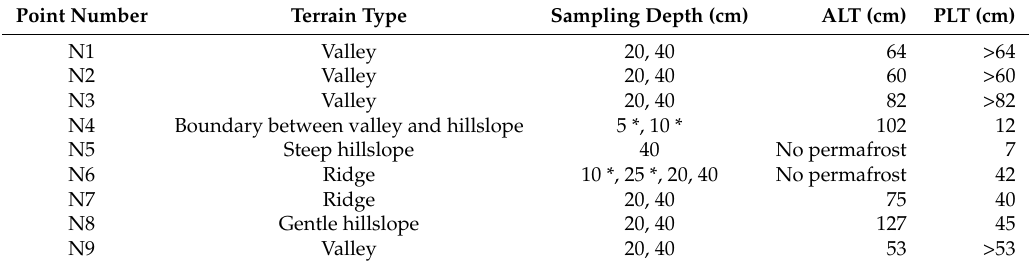
Table 1. Terrain type, sampling depth of soil pore waters, active layer thickness (ALT), and peat layer thickness (PLT) at nine sampling points of the research site in September 2016 (Tyrma, Khabarovsk, Russia). Pore waters at marked (*) depths at N4 and N6 were collected four times in May and twice a month from June to October. Other soil pore waters at nine sampling points were collected twice a month from June to